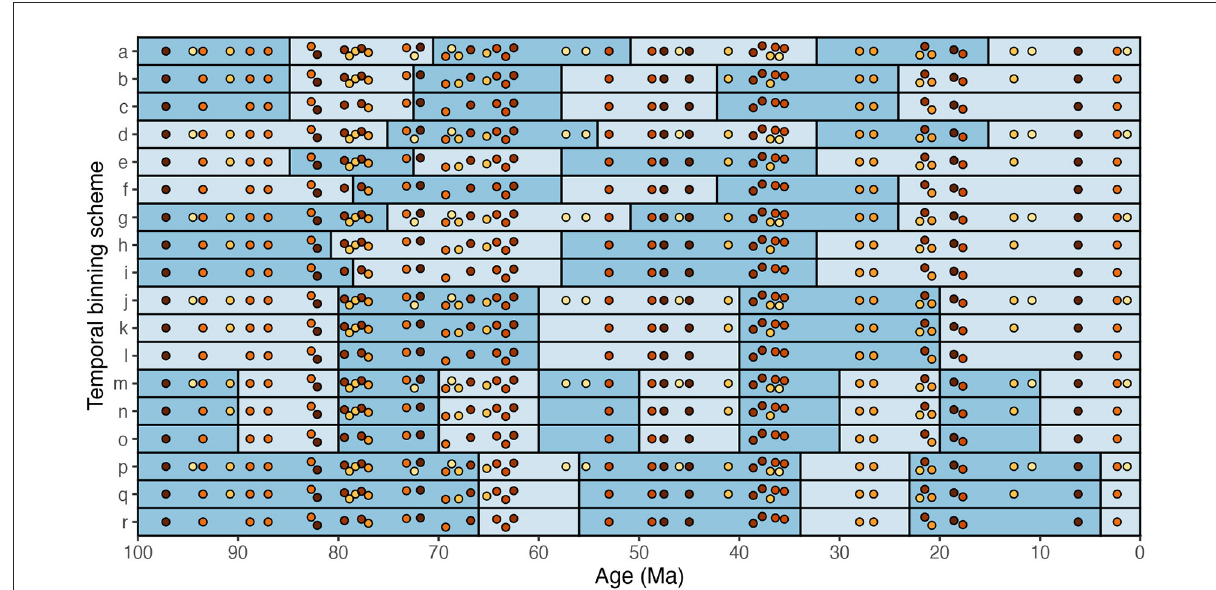
FIGURE8 A cartoon example of numerous, equally justifiable schemes for temporal binning of paleontological data. Each dot represents a fossil assemblage and is color-coded by the number of fossils measured therein: darker dots denote more fossils measured (a higher sample size). a–i were binned with k-means: a–c have six bins, d–f have five, and g–i have four. j–l were binned in 20-Myr increments. m–o were binned in 10-Myr increments. p–r were binned by geologic epoch. Binning schemes a,d,g,j,m, and p include all assemblages. Binning schemes b,e,h,k,n, and q exclude the nine assemblages with the lowest sample sizes. Binning schemes c,f,i,l,o, and r exclude the 18 assemblages with the lowest sample